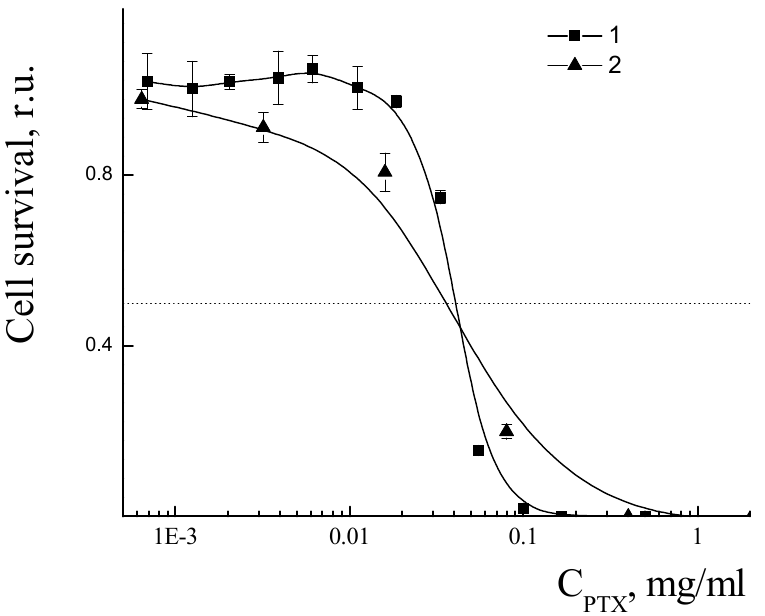
Figure 17. Cell viability in presence of PLAMs–us (1) and Paclitaxel-Teva (2).